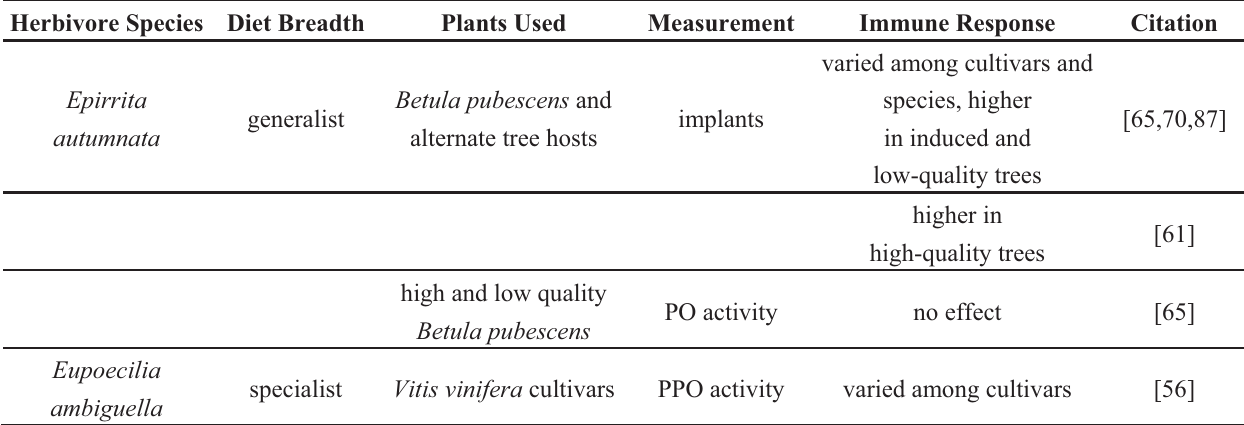
Table 1. Effects of host plant species and host plant quality on immune response of 9 specialist and generalist Lepidopteran